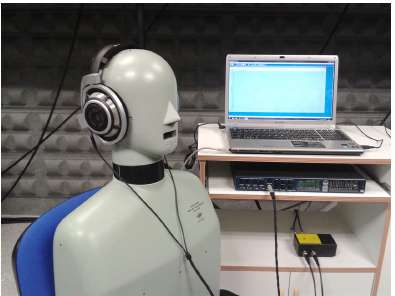
Figure 1. Set-up for measuring the headphones with the Head and Torso Simulator